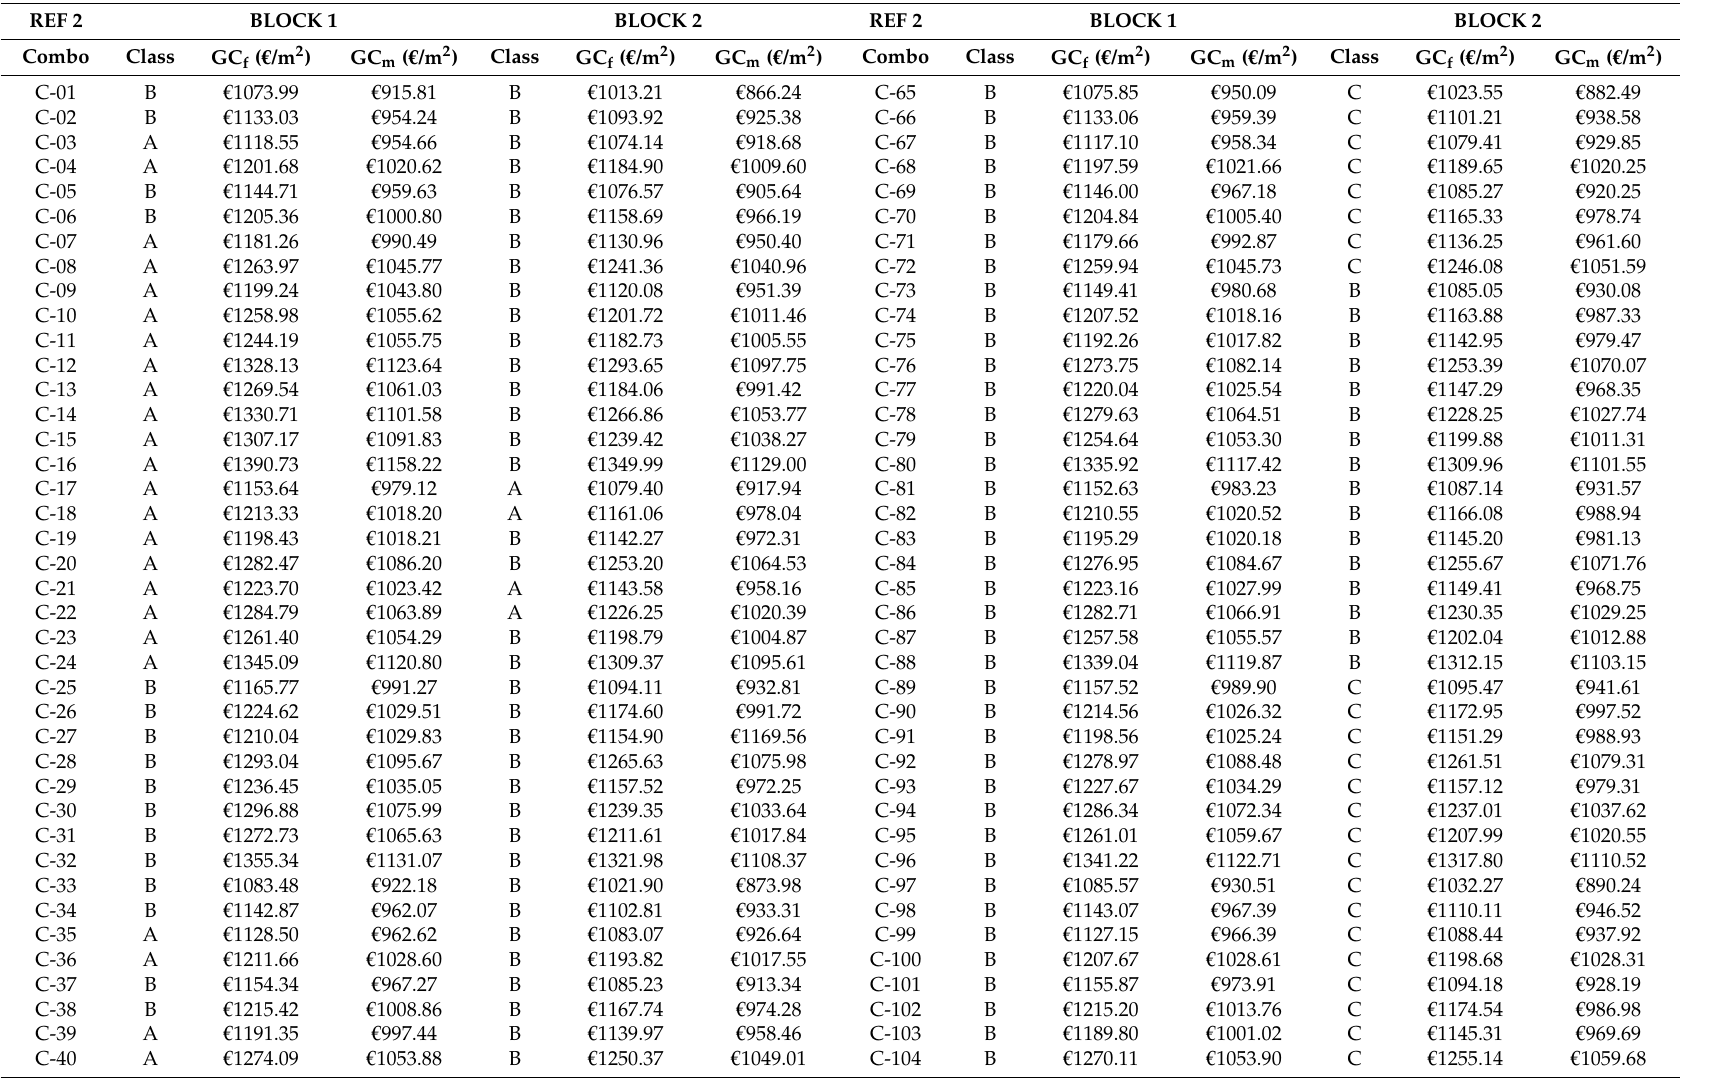
Table 11. Global cost for Reference building